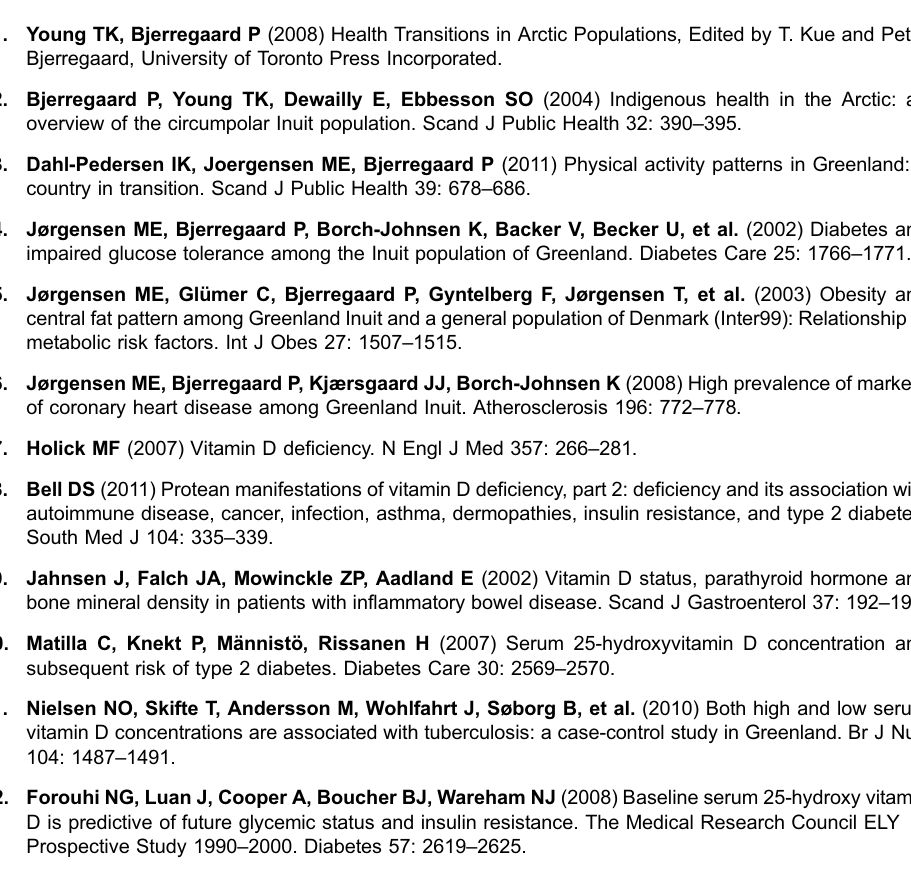
Table S2. Geometric mean intake of traditional food (g/d) among 2683 individuals included in the IHIT-study, 2005–2010, by gender and age